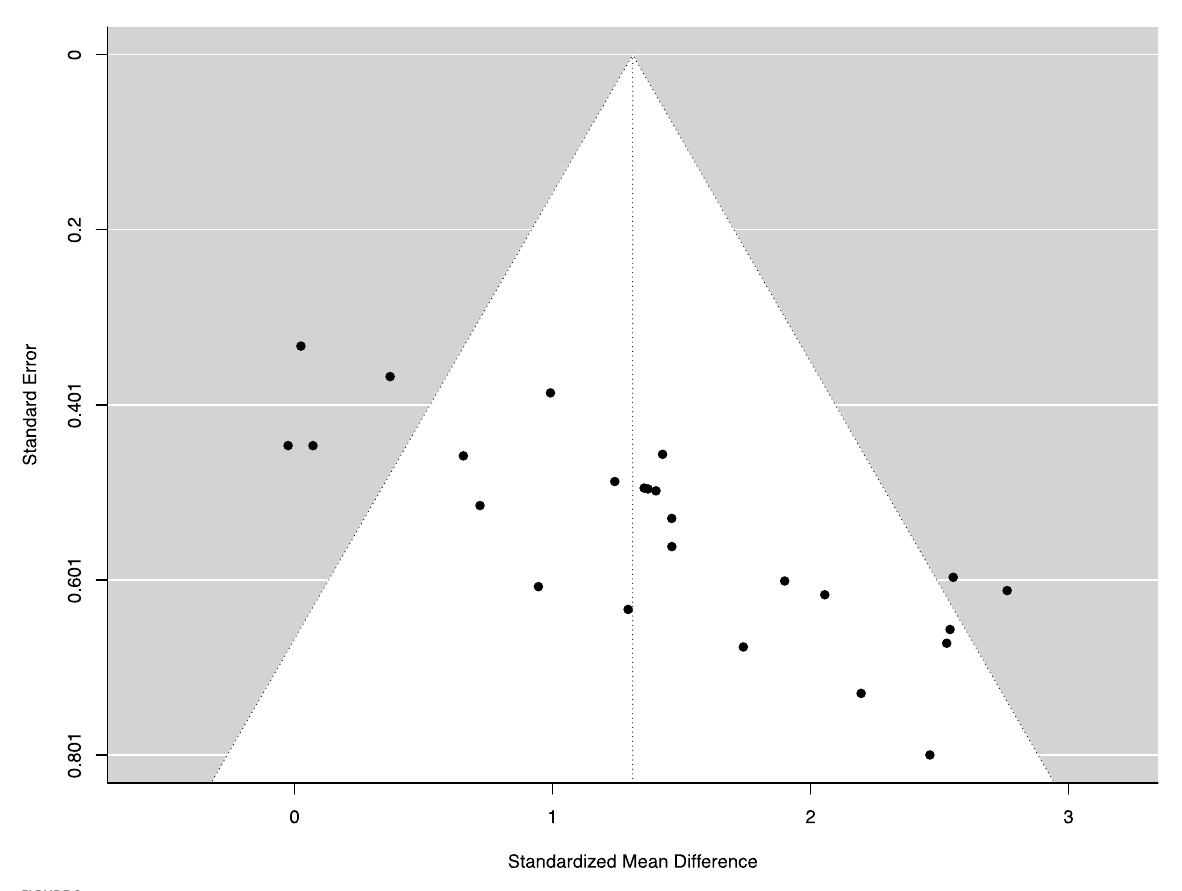
FIGURE2 Funnel plot of the standard differences in means vs. standard errors. The aggregated standard difference in means is the random effects mean effect size weighted by the degrees of freedom study